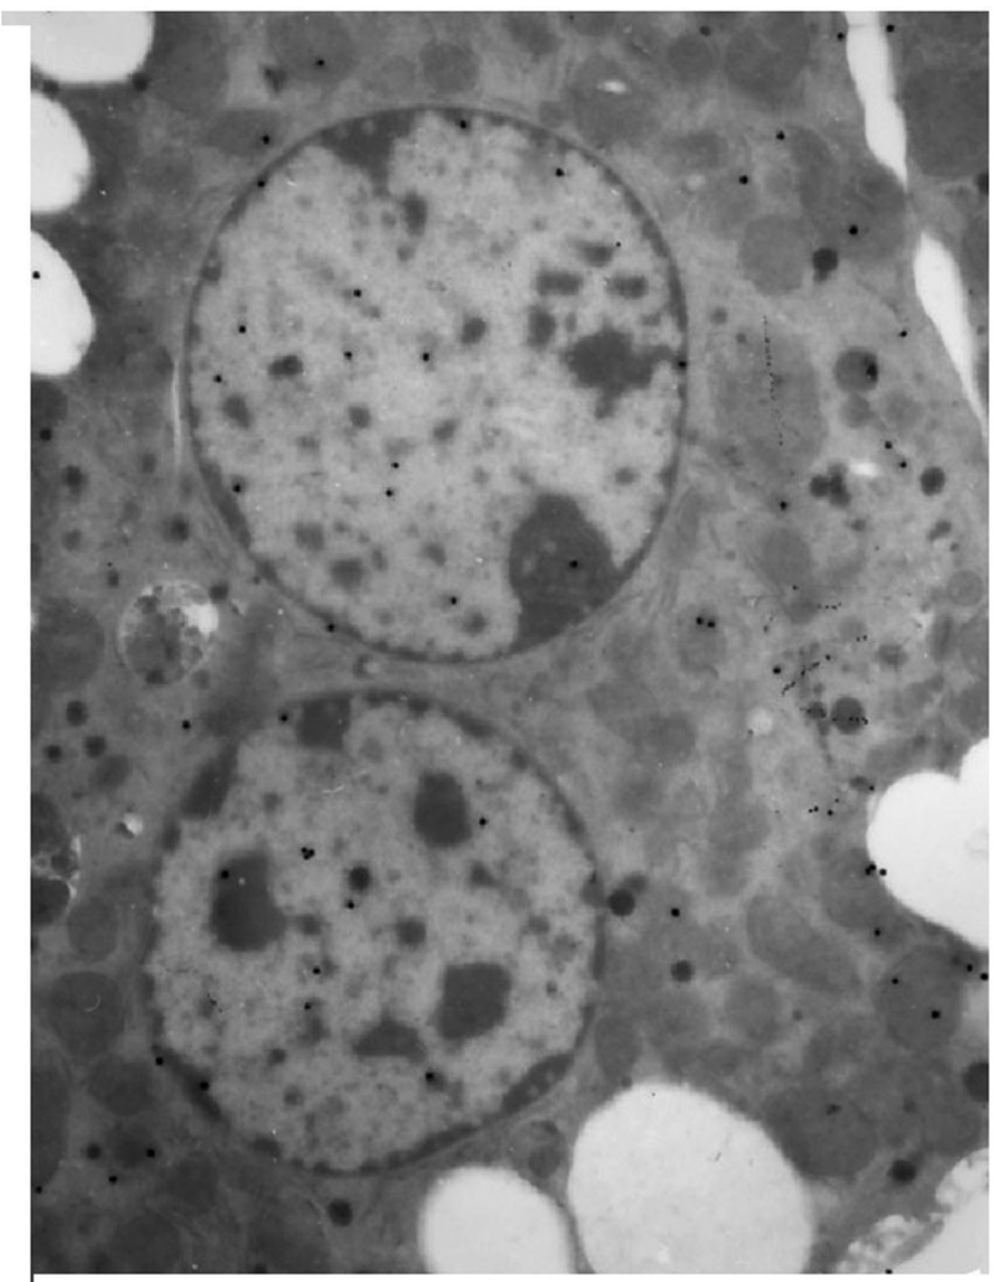
FIGURE 3 . High-power magnification electron microscopic radioautogram of a binucleate hepatocyte of an adult mouse aged at postnatal month 2, labeled with 3 H-leucine, showing protein synthesis. Many silver grains due to 3 H- leucine can be seen in the two nuclei, especially over the euchromatin as well as over many mitochondria throughout the cytoplasm. ×